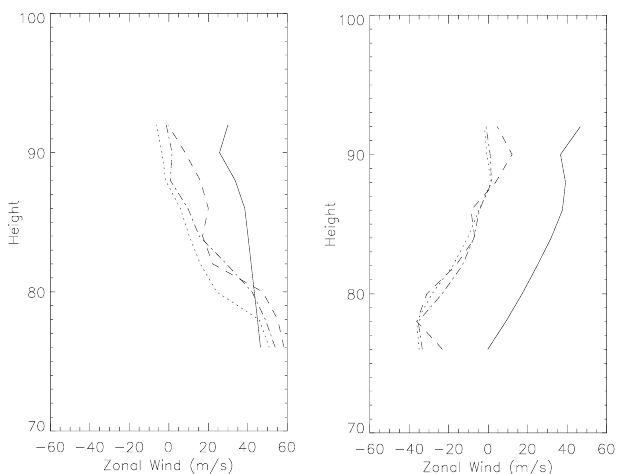
Fig. 3. ‘‘Seasonal’’ average of the zonal winds from winter (left hand panel) and summer (right hand panel). The solid line represents the HRDI data, the dashed line the two-hour bin, the dot-dashed line the six-hour bin and the dotted line the twelve-hour bin